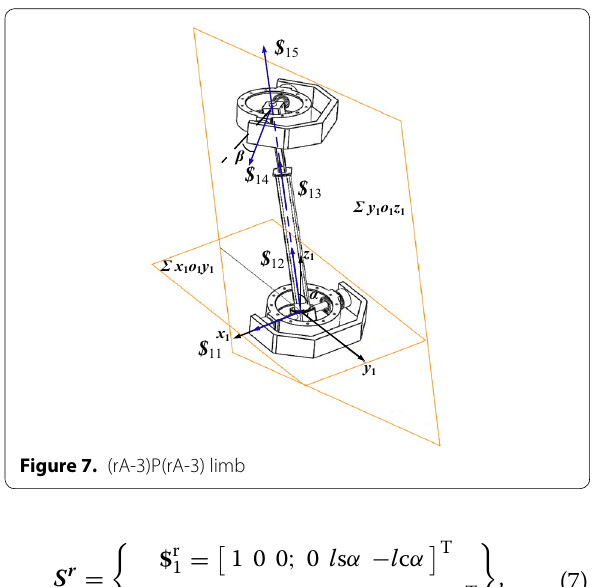
Figure 7. (rA-3)P(rA-3) limb